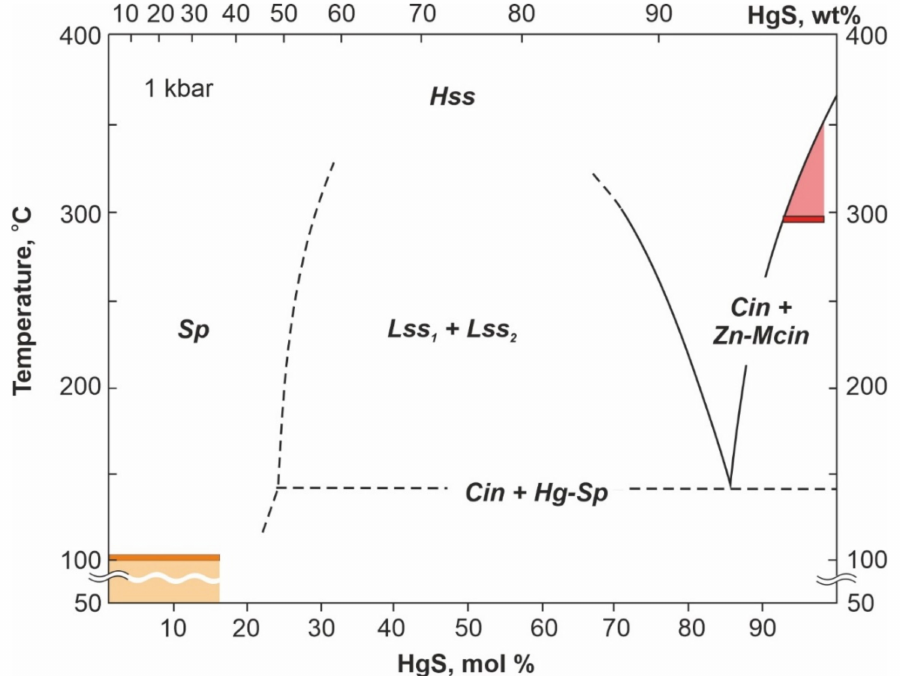
Figure 20. Phase diagram of the system ZnS–HgS after [4]. Brownish (sphalerite) and purple (zincian metacinnabar) colors highlight the composition ranges of sulfides from mud masses of Pugachev and South Sakhalin MVs, Sakhalin Island. Cin = cinnabar. Hg-Sp = mercury sphalerite. Hss = high- temperature (Zn,Hg)S solid solution with sphalerite structure. Lss = low-temperature solid solution. Sp = sphalerite. Zn-Mcin = zincian metacinnabar. Minimal temperature of metacinnabar formation was estimated as high as 295 ◦ C based on its Zn content. Temperature interval (50–106 ◦ C) of